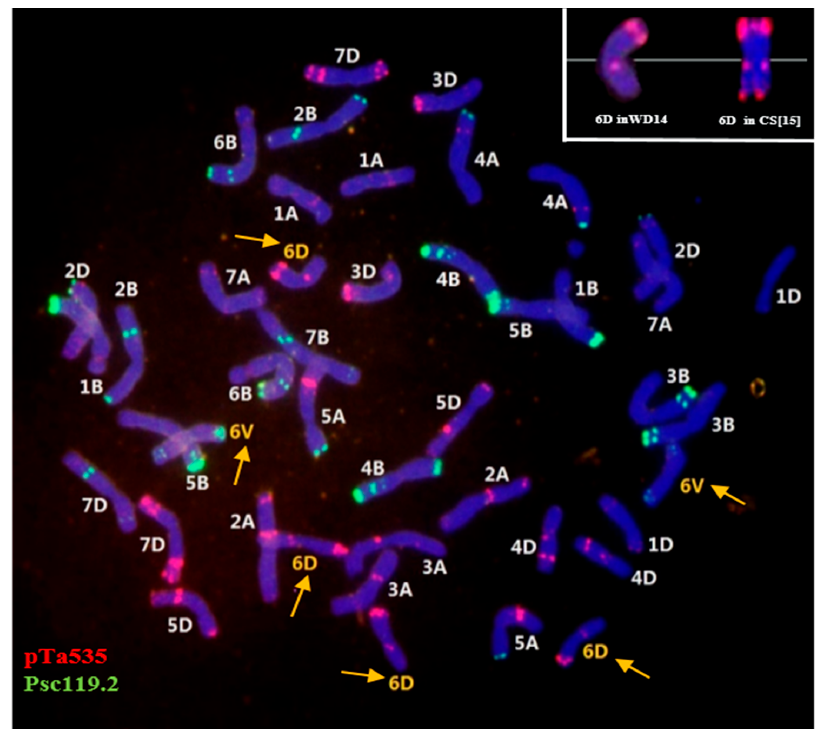
Figure 1. Fluorescence in situ hybridization was performed on mitotic chromosomes of WD14 by using oligo-pTa535-1 (red) and oligo-pSc119.2-1 (green) as probes. Yellow arrows indicate the four 6D chromosomes and two alien chromosomes 6V from Dasypyrum villosum . Chromosomes were counterstained with 4 ′ -6-diamidino-2-phenylindole (blue). Table 1. The frequency of normal chromosomes (N) and aberrations (A) in the M 0 generation treated with γ -irradiation at doses of 100, 200, and 300 Gy.